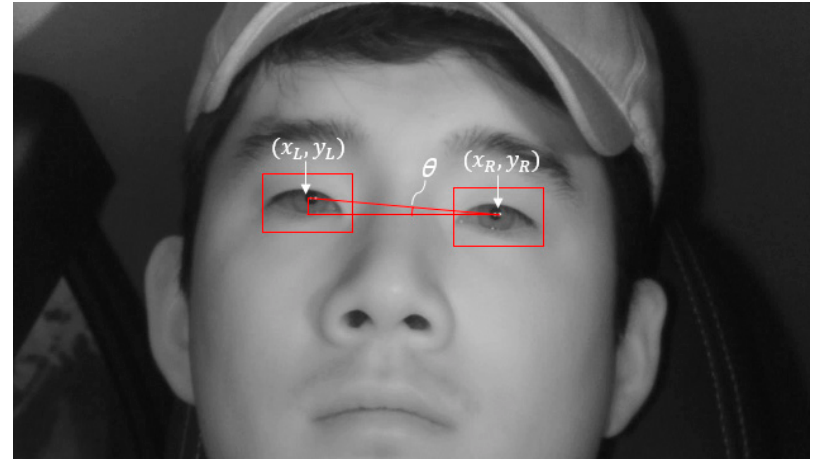
Figure 7. An example of measuring θ using the center coordinates of left and right eye boxes.